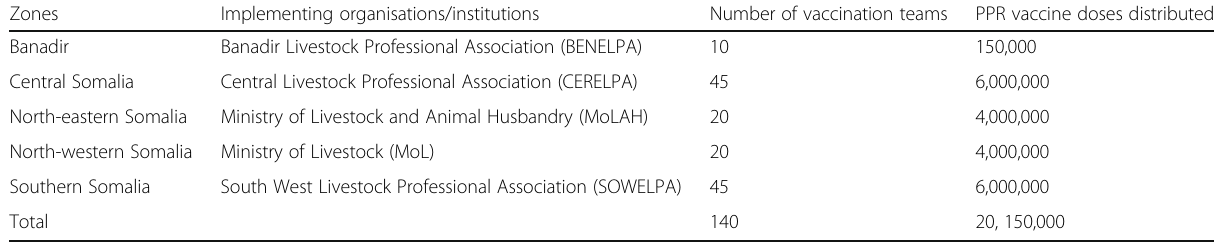
Table 3 The distribution of PPR vaccine doses in the five zones according to the implementing organisations and public institutions,